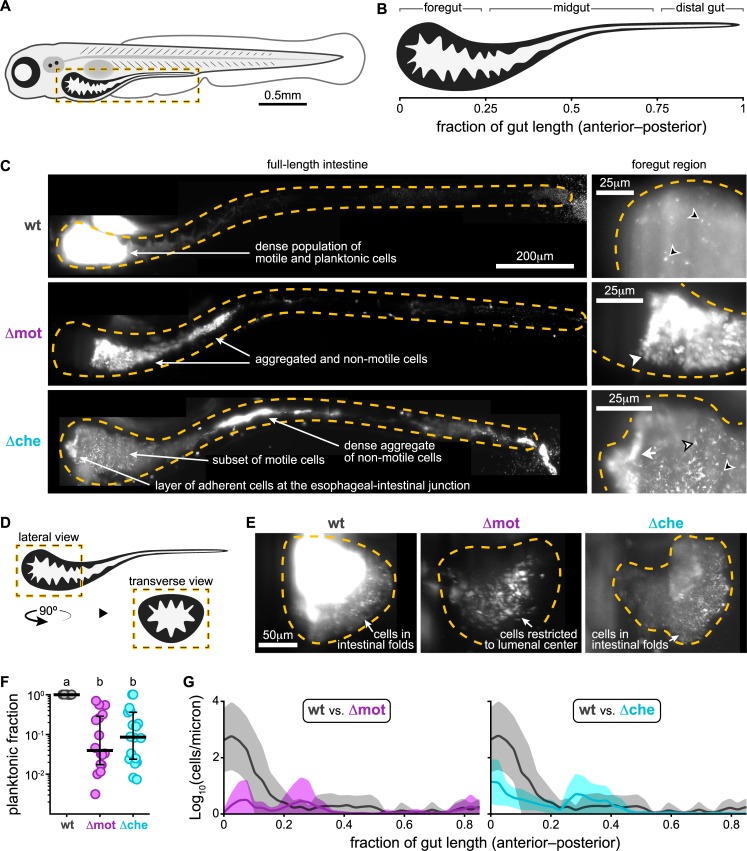
Motility and chemotaxis mutants have altered intestinal spatial organization.(A) Cartoon of a 6-day-old zebrafish. Dashed box marks intestinal region imaged by LSFM. (B) Anatomical regions of the larval zebrafish intestine. (C) Maximum intensity projections acquired by LSFM showing the spatial organization of wt Vibrio (top), Δmot (middle), and Δche (bottom) within the intestine. Top right inset shows a zoomed-in view of wt Vibrio cells in a separate fish that was colonized with a 1:100 mixture of green- and red-tagged variants so that the cellular organization of the dense Vibrio population could be discerned. The dilute channel (green) is shown. Dashed lines mark approximate intestinal boundaries. Open arrowheads: single bacterial cells; solid arrowheads: small aggregates; tailed arrowheads: large aggregates. Arrowheads with a black stroke mark swimming cells, which appear as comet-like streaks. (D) Cartoon showing the intestinal region pictured in panel E. (E) Maximum intensity projections acquired by LSFM showing transverse view of the foregut region colonized with wt, Δmot, or Δche. (F) Fraction of planktonic cells contained within each strain’s population. Each circle is a measurement from a single intestinal population. Bars denote medians and interquartile ranges. Letters denote significant differences. p < 0.05, Kruskal-Wallis and Dunn’s multiple comparisons test. (G) Image-derived abundances of wt (n = 7), Δmot (n = 4), and Δche (n = 5) with respect to position along the length of the gut. Shaded regions mark confidence intervals. Underlying data plotted in panels F and G are provided in S1 Data. LSFM, light sheet fluorescence microscopy; wt, wild type.